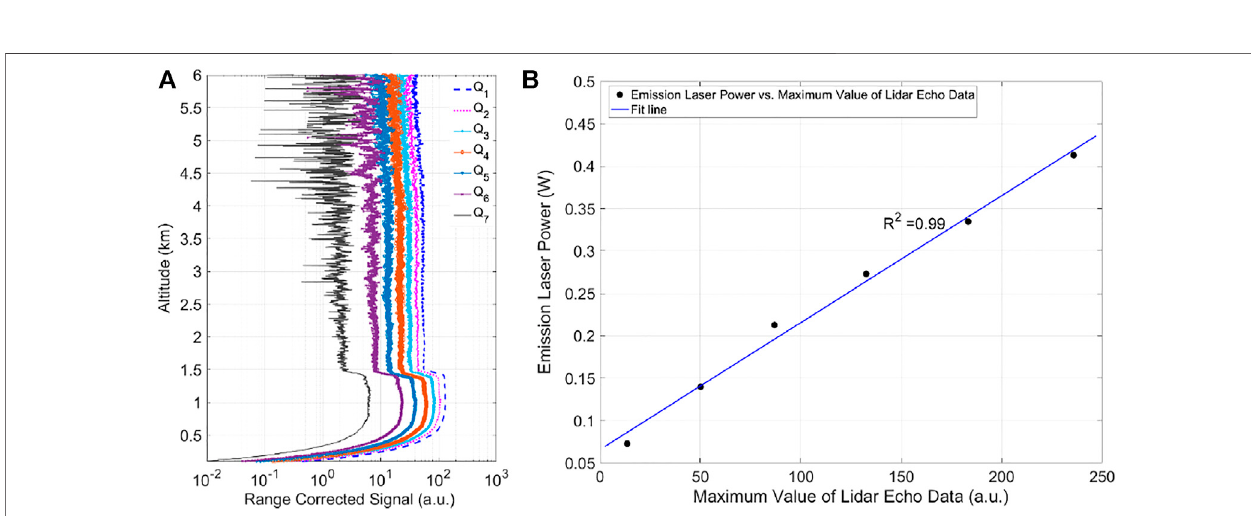
FIGURE6|(A) Theechosignalpro fi lesobtainedwithdifferentemissionlaserpowers. (B) The fi ttinglineoftheemissionlaserpowersandthemaximumvalueofthe echo signal pro fi les.